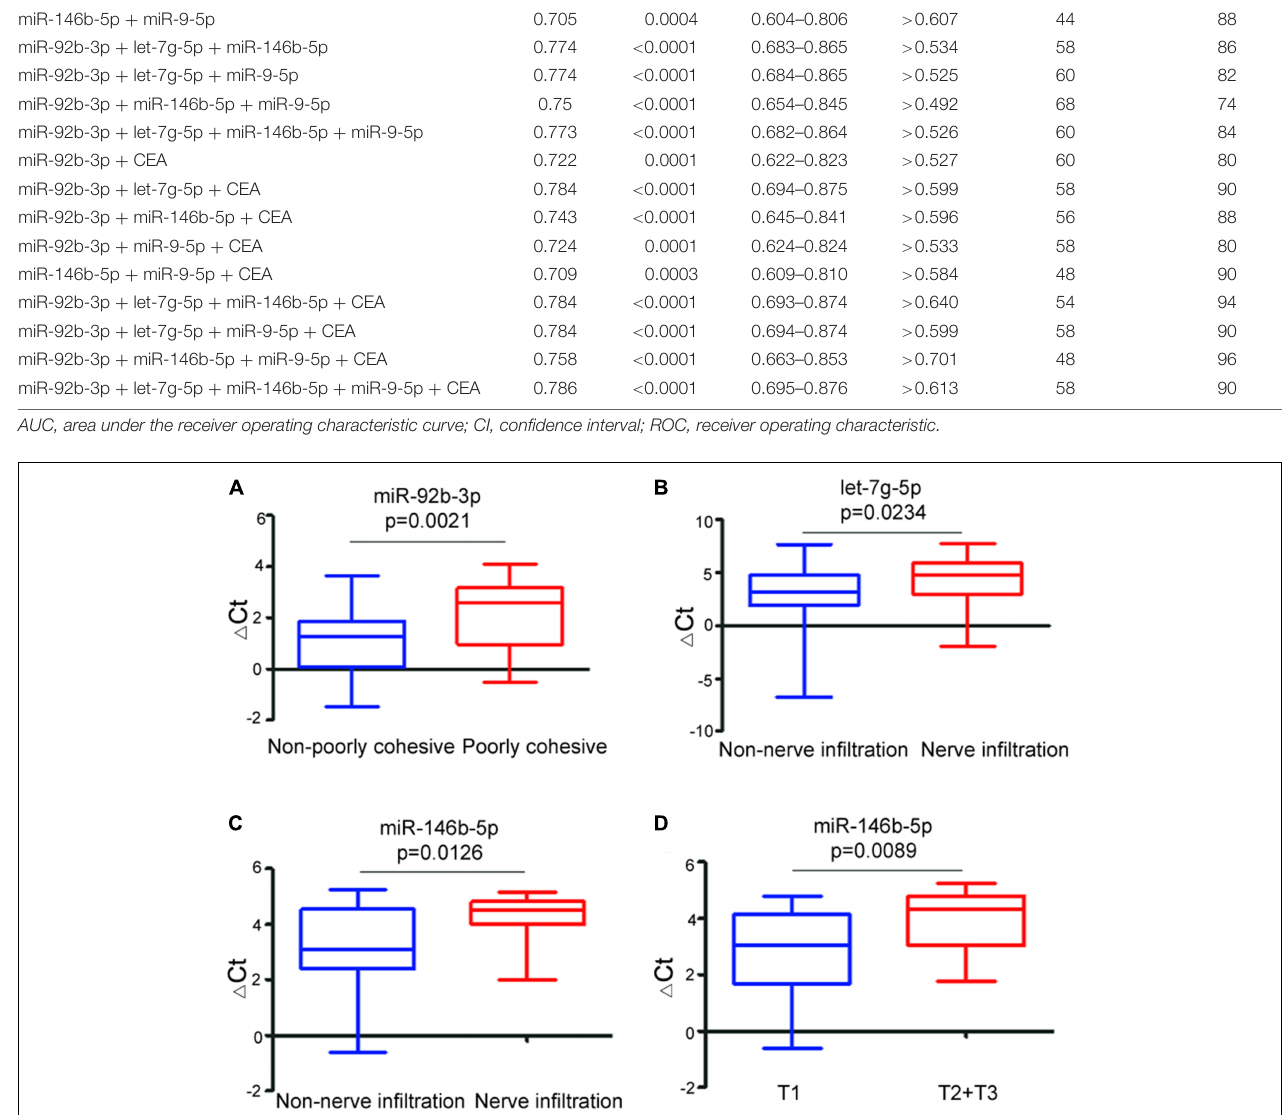
efficacies than traditional biomarker CEA in early-stage